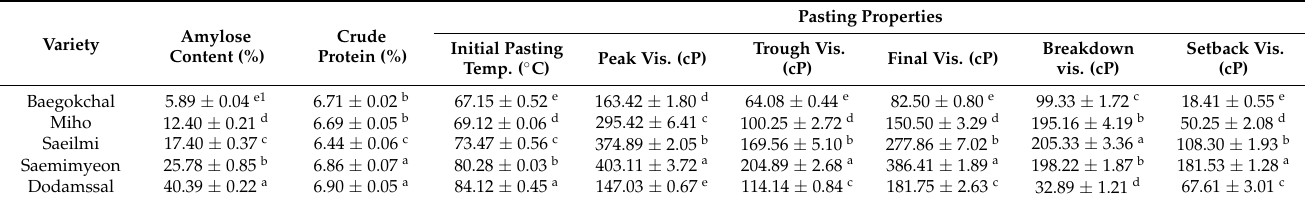
Table 1. Amylose, crude protein, and pasting properties of processed